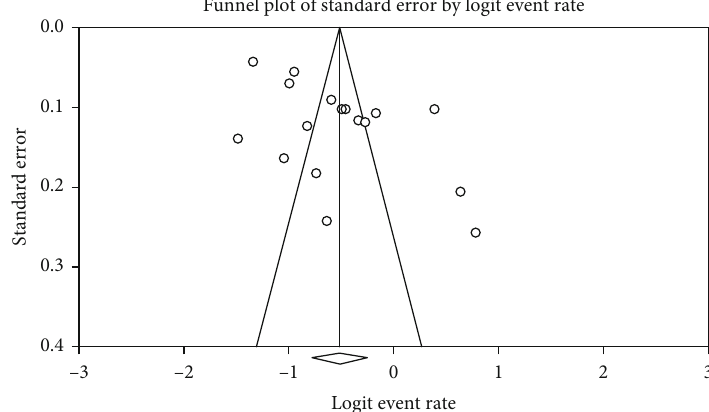
Figure 1: Funnel plot of results of the prevalence of cardiovascular disease in patients with type 2 diabetes mellitus (DM). Records identified through database searching